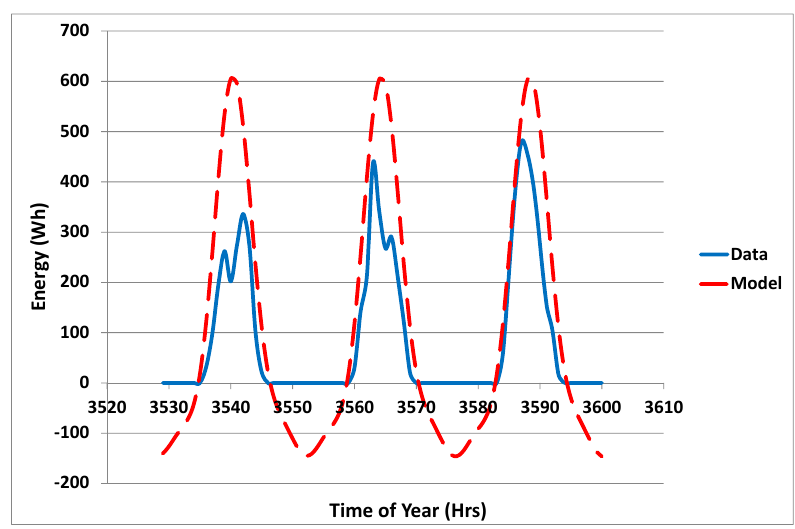
Figure 1. Power spectrum for hourly solar radiation for Mildura data.